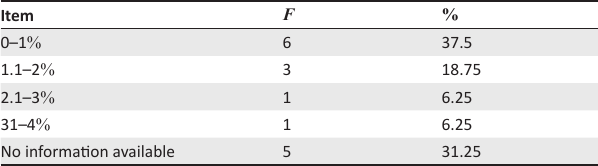
TABLE 10: Percentage of annual payroll organisations spend on Employee Wellness